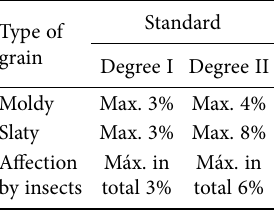
Table 4. Biophysical standards of